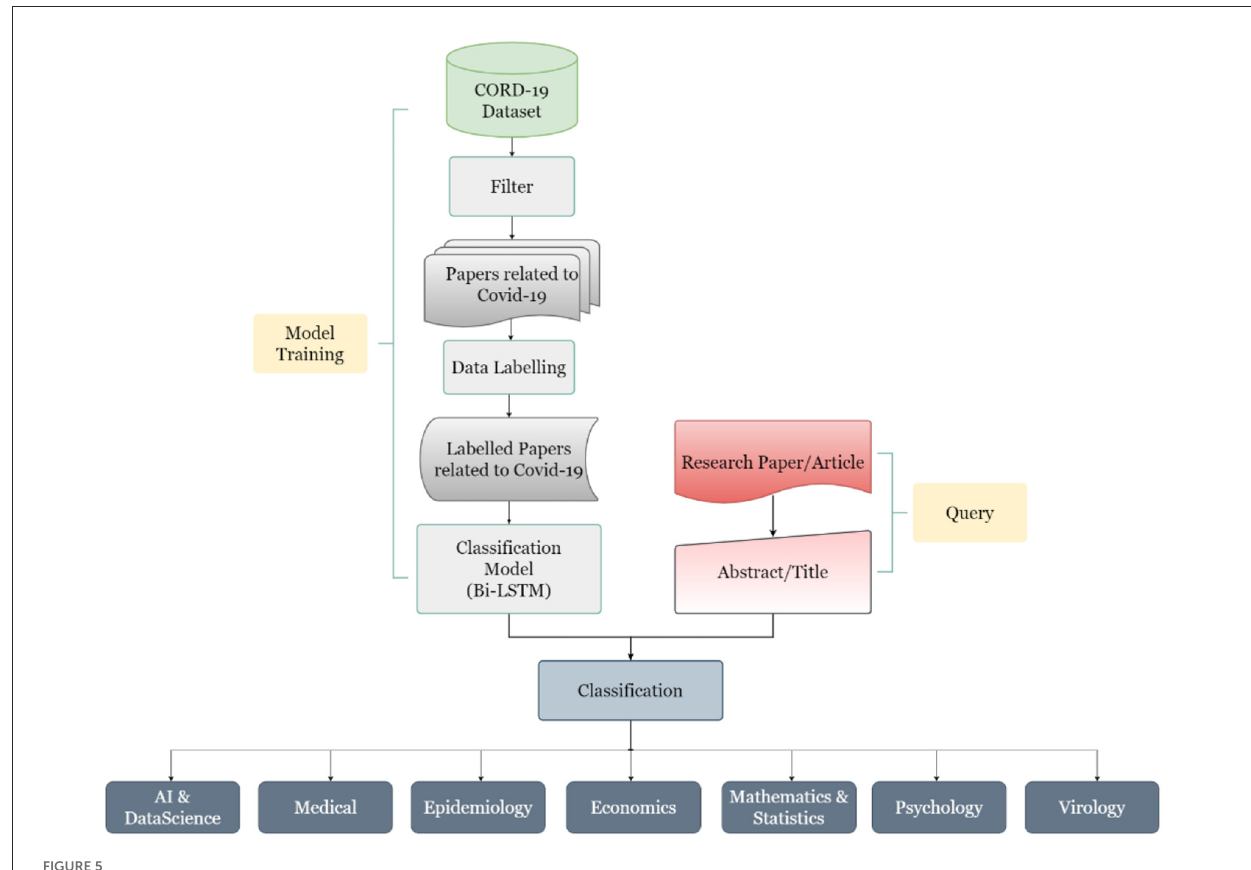
FIGURE5 The workflow diagram of the AI-enabled research support tool process.